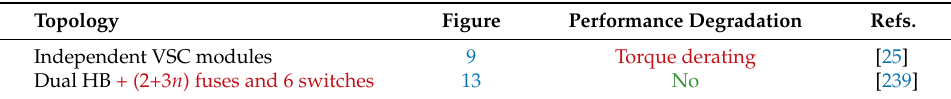
Table 26. Methods for tolerating dc-link power-supply OC/SC faults (Section 12.2) in multiphase applications in the